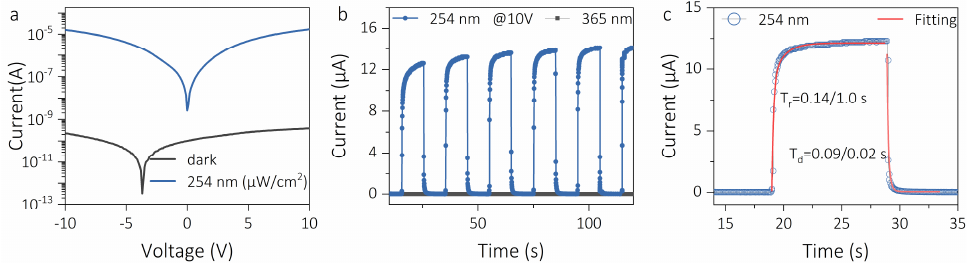
Figure 2. ( a ) I – V curves of the ε-Ga 2 O 3 -thin-film-based solar-blind ultraviolet photodetector under 254 nm and dark conditions. ( b ) Time-dependent photoresponse curves under 254 nm and 365 nm light. ( c ) Amplified single-period photoresponse and time fitting curve.